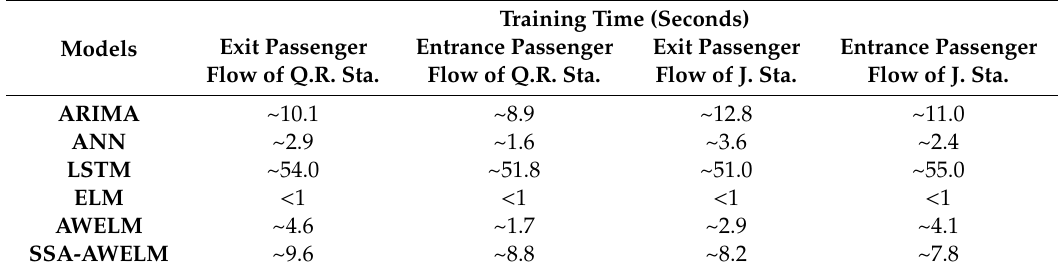
Table A2. The training time of the experimental